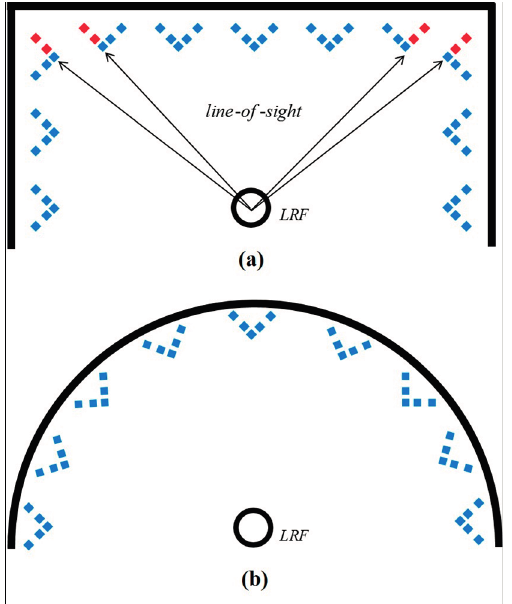
Figure 4. Establishment of the double-deck calibration